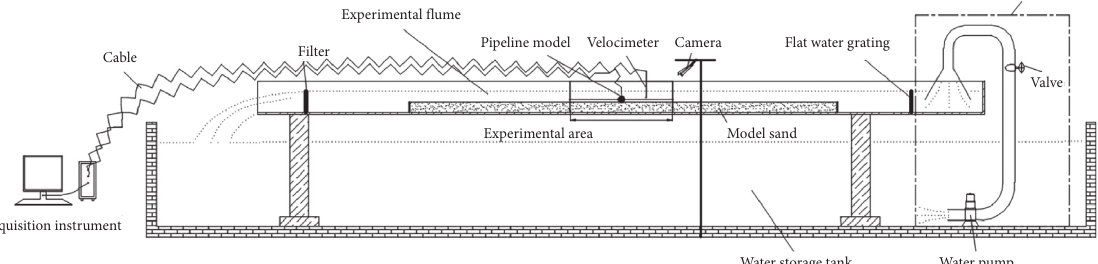
Figure 3: Schematic of the